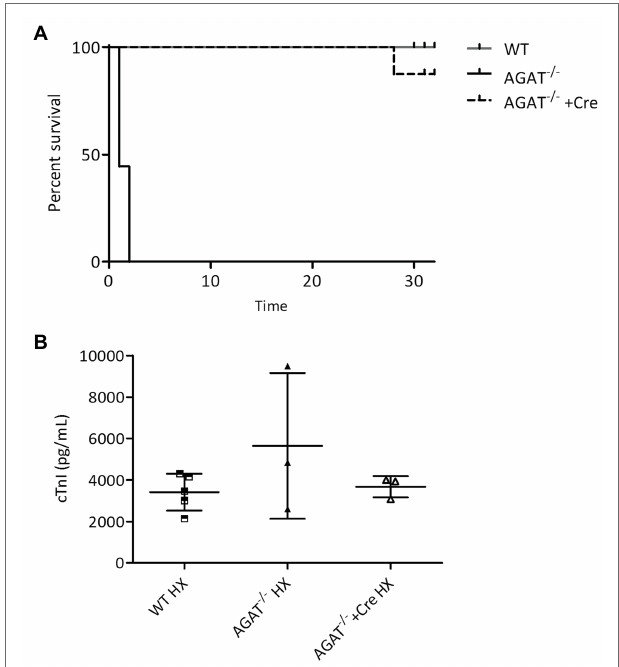
FIGURE 2 | Kaplan–Meier survival analysis and cardiac troponin I (cTnI). (A,B) Outcome of Agat − / − mice with and w/o creatine (Cre) supplementation and WT littermates in hypoxia (HX). (A) Kaplan–Meier survival analysis of Agat − / − mice ( n = 9), WT littermates (WT, n = 17) and Agat − / − mice supplemented with 1% creatine from weaning ( Agat − / − +Cre, n = 8). All mice were kept in hypoxia and followed for up to 32 days. (B) cTnI in Agat − / − mice